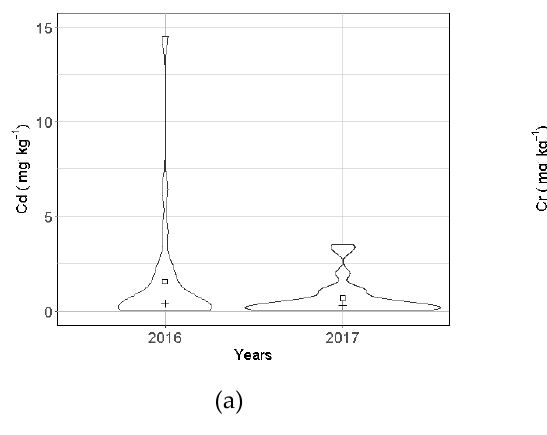
Table 6. The characteristic concentrations of heavy metals (mg.kg −1 ) in the Warta River bottom sediments in 2016 and